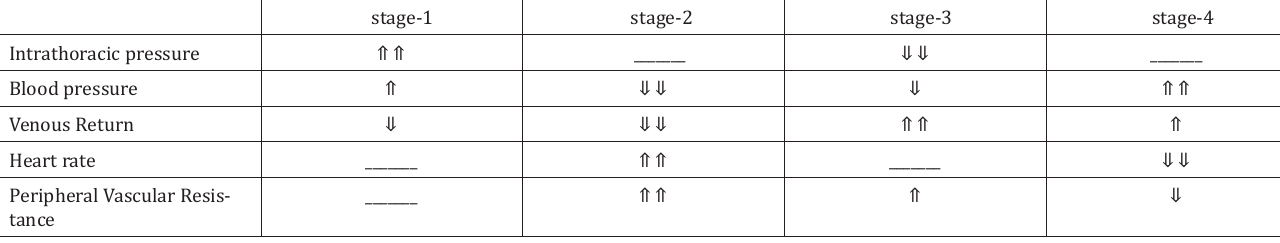
Cardiovascular changes occurring during Valsalva